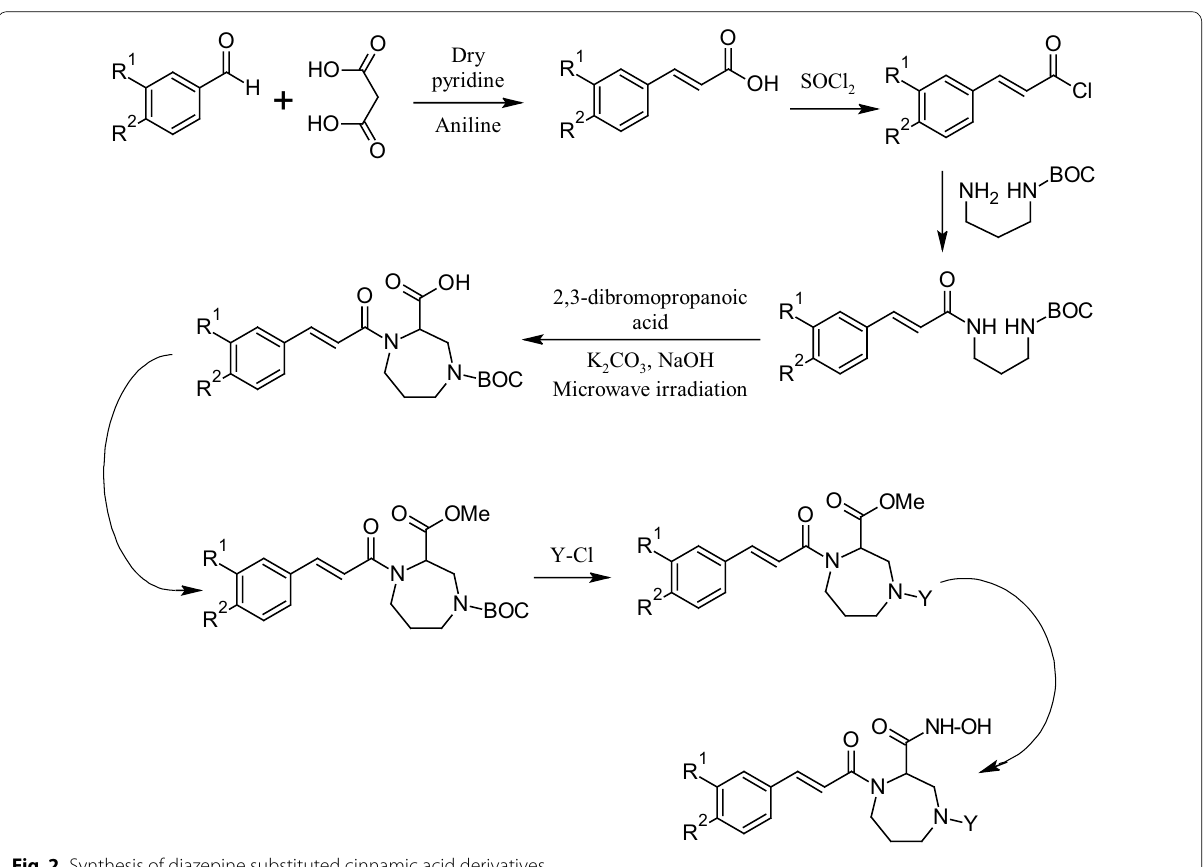
Fig. 2 Synthesis of diazepine substituted cinnamic acid